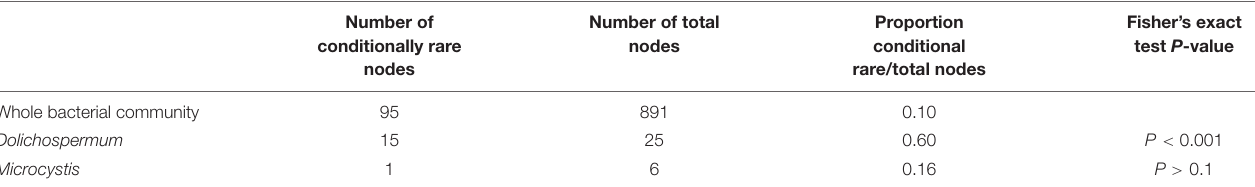
TABLE 1 | Conditionally rarity